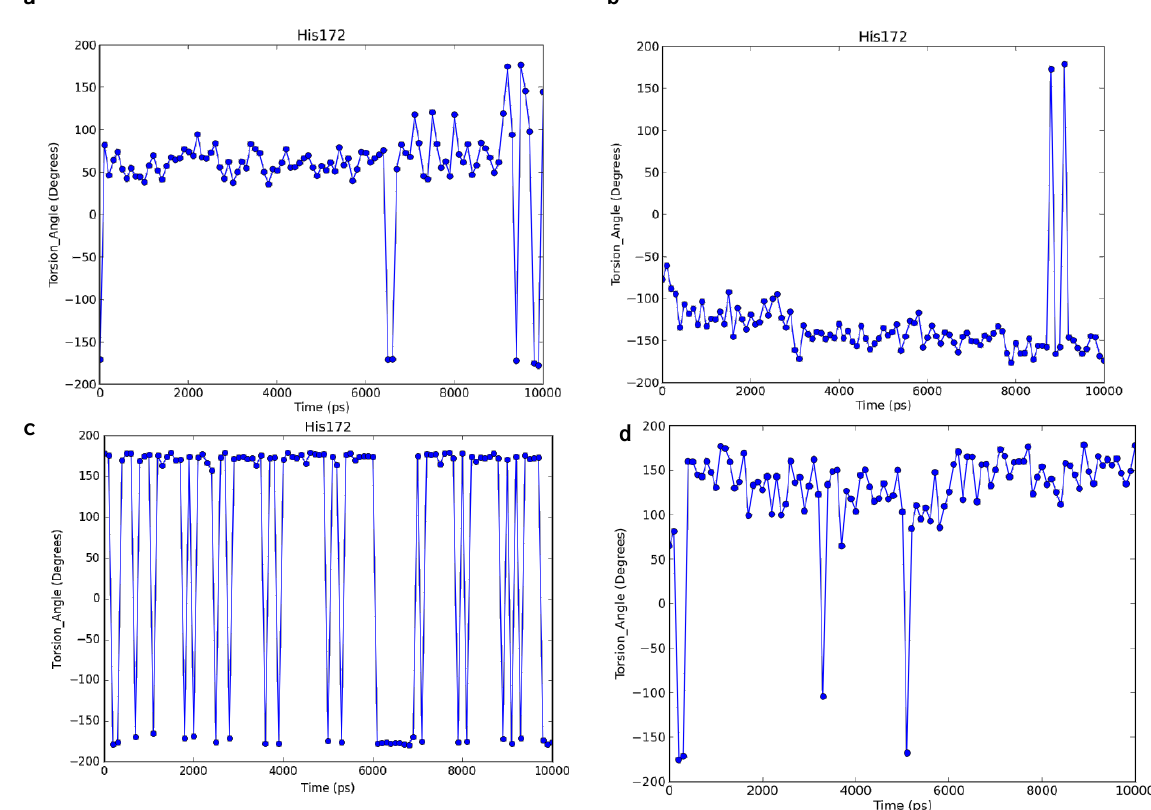
Figure S10. Torsion angles of His172 residue during MD simulations of (a) 10 (b) 19 (c) 21 and (d) 25 /1XFC